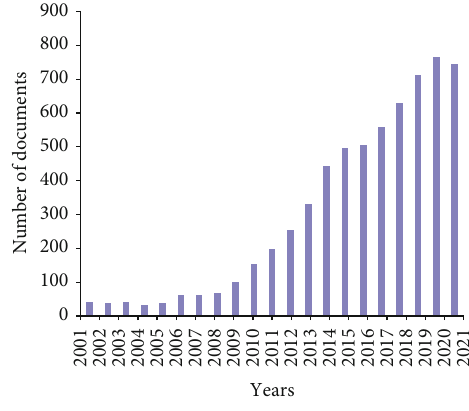
Figure 1: Studies on mismatch losses in the solar photovoltaic systems since